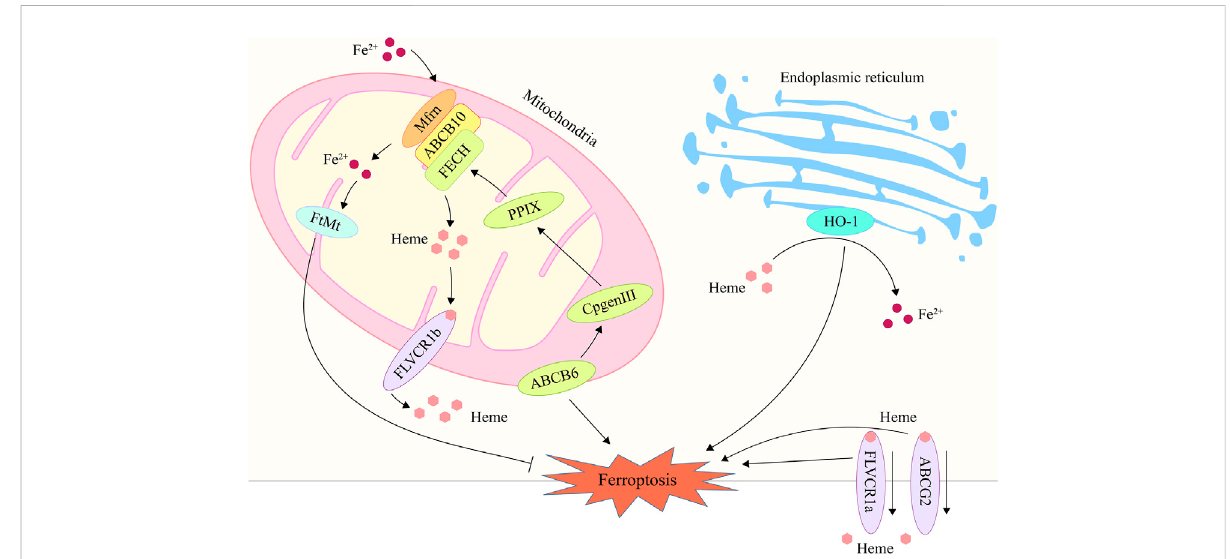
FIGURE 1 The processes of heme metabolism and mitochondrial iron metabolism are implicated in ferroptosis. In the endoplasmic reticulum, HO-1 degrades heme and releases iron ions, hence raising intracellular iron content and promoting ferroptosis. ABCB6 stimulates heme production by transferring CPgenIII from the cytosol to the mitochondrial membrane gap, a process that may play a role in ferroptosis. By exporting heme via the plasma membrane, ABCG2 and FLVCR1 contribute to the control of ferroptosis. Mfrn is capable of transporting iron through the inner membrane and into the mitochondrial matrix, hence elevating the iron concentration in mitochondria and inducing ferroptosis. FtMt may store free iron in mitochondria, hence reducing iron concentration and inhibiting ferroptosis. HO-1, heme oxygenase 1; ABCB6, ATP-binding cassette sub- family B member 6; ABCG2, ATP-binding cassette subfamily G member 2; Mfrn, mitoferrin; FtMt, mitochondrial